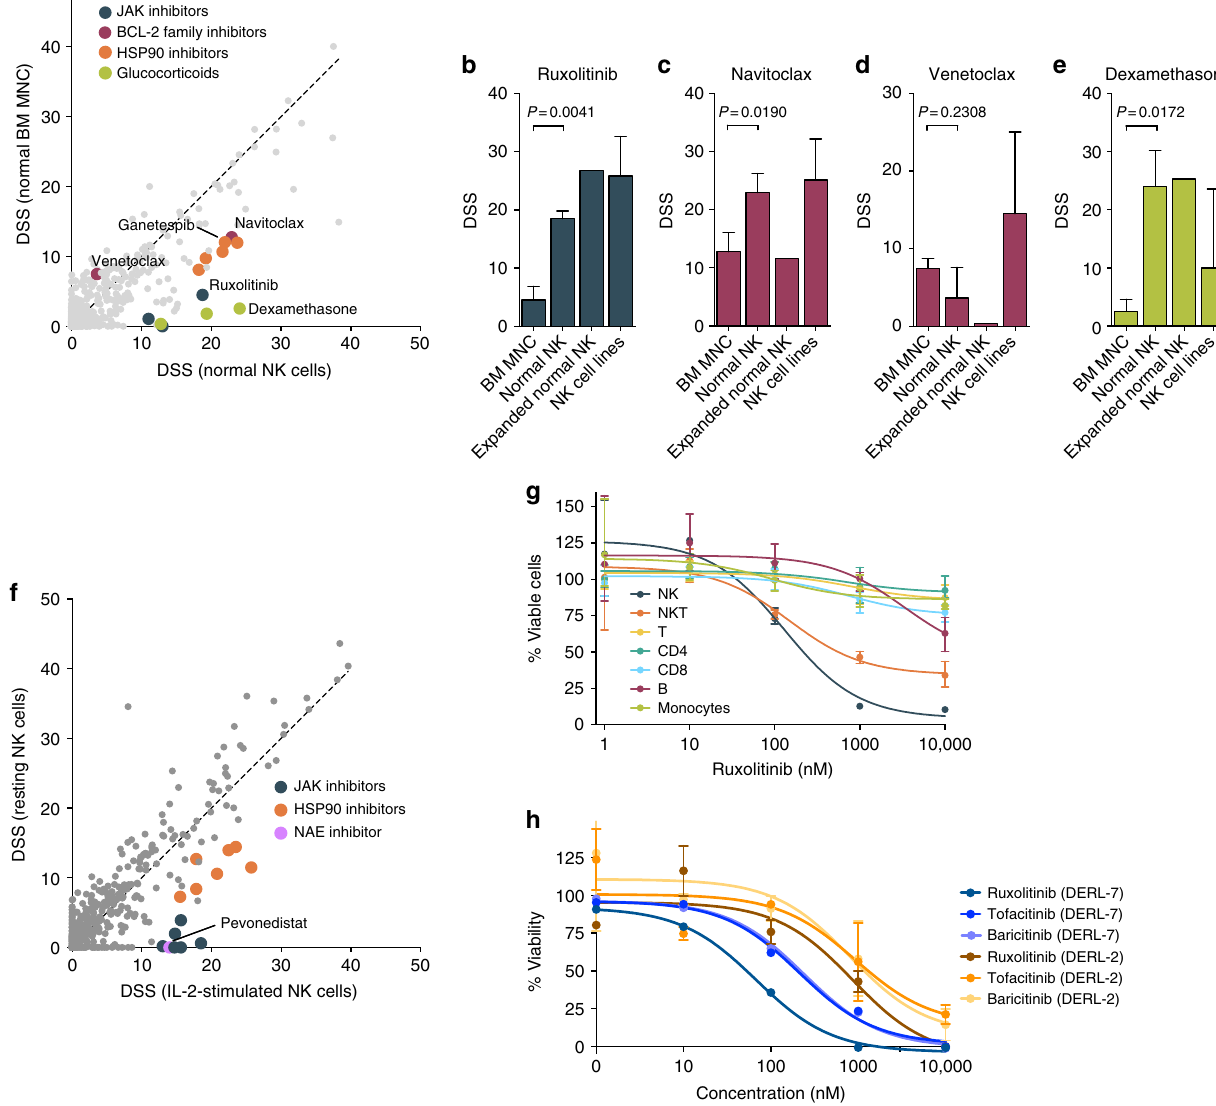
Fig. 4 Drug response pattern characteristic of NK cells. a Drugs speci fi c to normal NK cells compared to other hematopoietic cells. Scatter plot comparing median DSS of normal primary NK cells stimulated with 2.5 ng/mL IL-2 ( n = 3) to median DSS of unstimulated normal bone marrow mononuclear cells (BM MNC, n = 3). b – e Comparison of drug responses of NK cells (normal IL-2-stimulated NKs, normal K562-aAPC-activated NKs and NK cell lines) and normal BM MNC to ruxolitinib ( b ), navitoclax ( c ), venetoclax ( d ) and dexamethasone ( e ). Bar height indicates mean DSS and error bars indicate standard deviation. P values were calculated using Welch ’ s t -test. f Inhibition of IL-2 signaling by JAK, HSP90 and NAE inhibitors. Scatter plot comparing DSS of resting ( n = 1) and IL-2-stimulated normal primary NK cells ( n = 1). g Ruxolitinib dose – response curves of different PBMC populations in the presence of 2.5 ng/mL IL-2. Shown are representative results from one out of two experiments. Dots indicate mean and error bars the range of three replicate wells. h JAK inhibitor dose – response curves of the cell lines DERL-7 (NK-cell characteristics) and DERL-2 (T-cell characteristics) established in parallel from the same patient with γδ lymphoma. Both cell lines were cultured in 2.5 ng/mL IL-2. Dots indicate mean and error bars the range of two